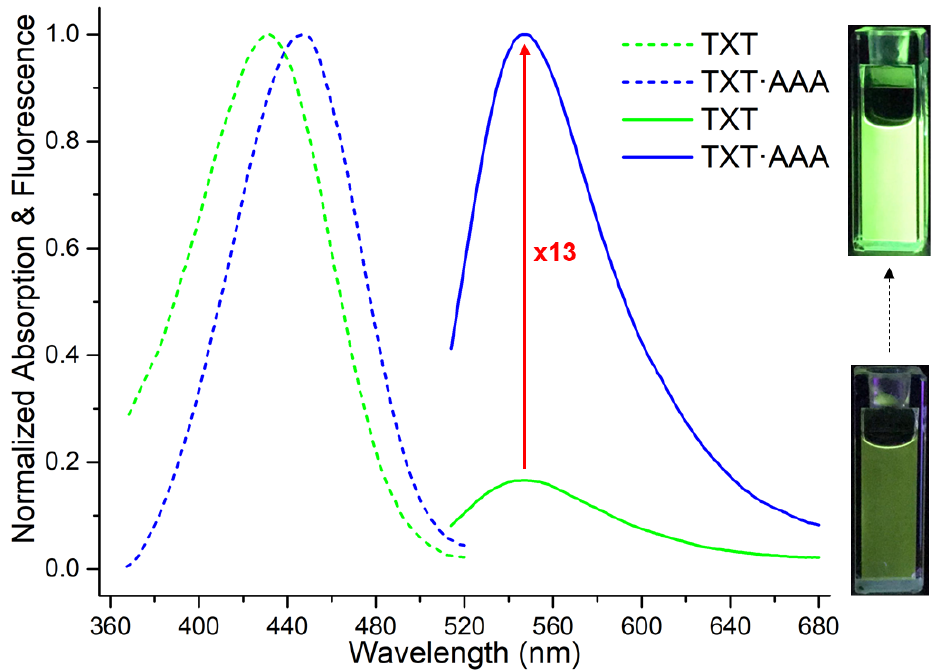
Table 3. Spectroscopic properties of TXT labeled with AlMF .